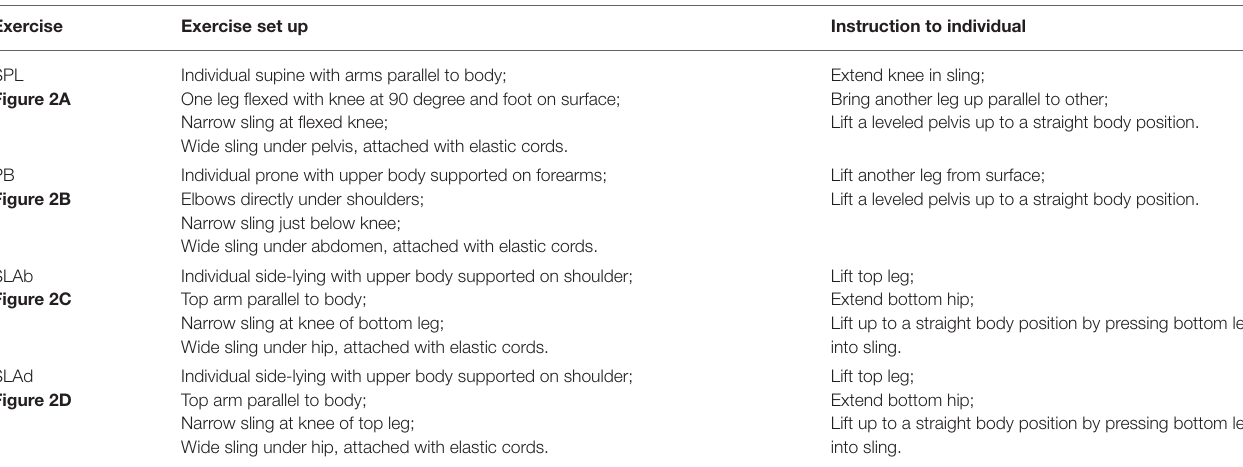
TABLE 1 | Principles of exercise using the sling exercise. Exercise Exercise set up Instruction to individual SPL Figure 2A